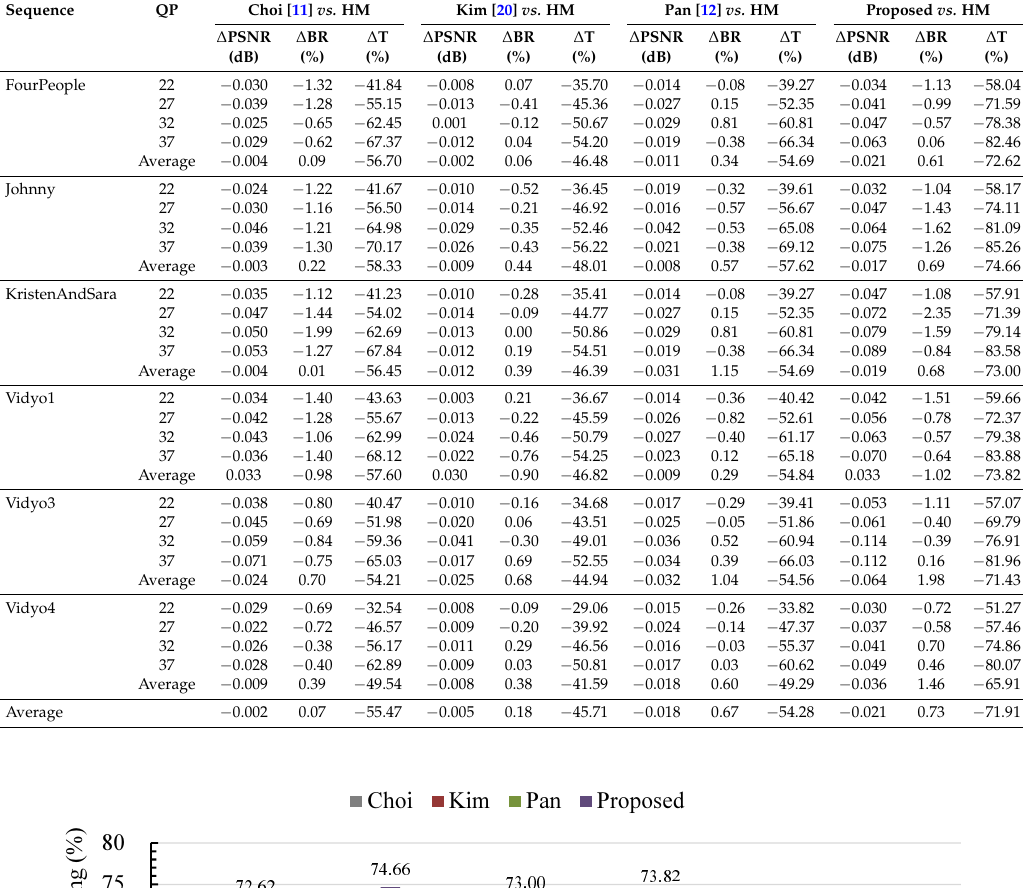
Table 2. Summary of the encoding results. BR, bit rate.